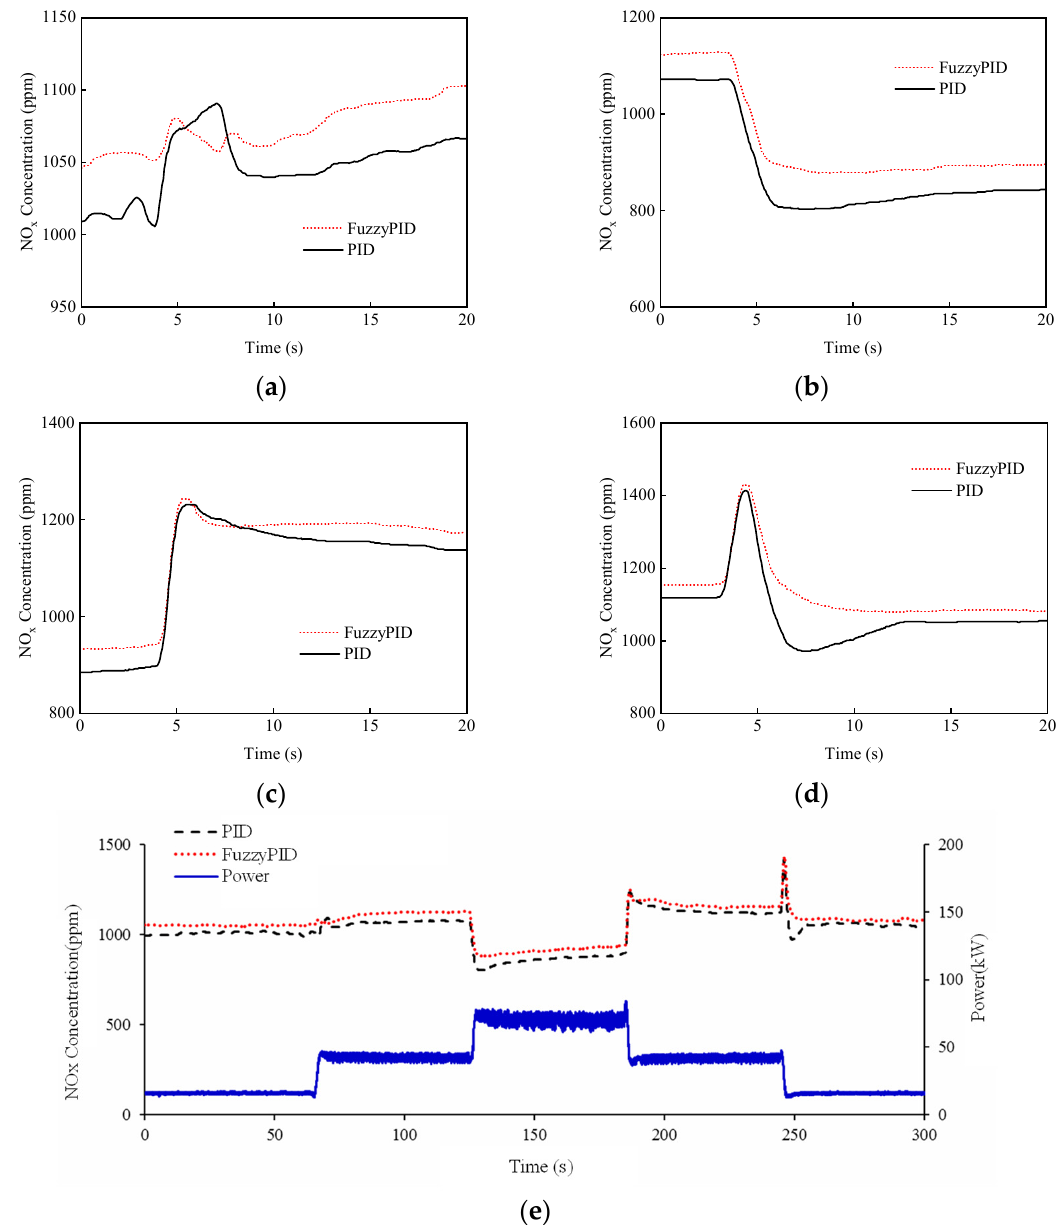
Figure 6. The NOx emission characteristics in the process of working condition switching: ( a ) switching 1; ( b ) switching 2; ( c ) switching 3; ( d ) switching 4; ( e ) overall switching process.